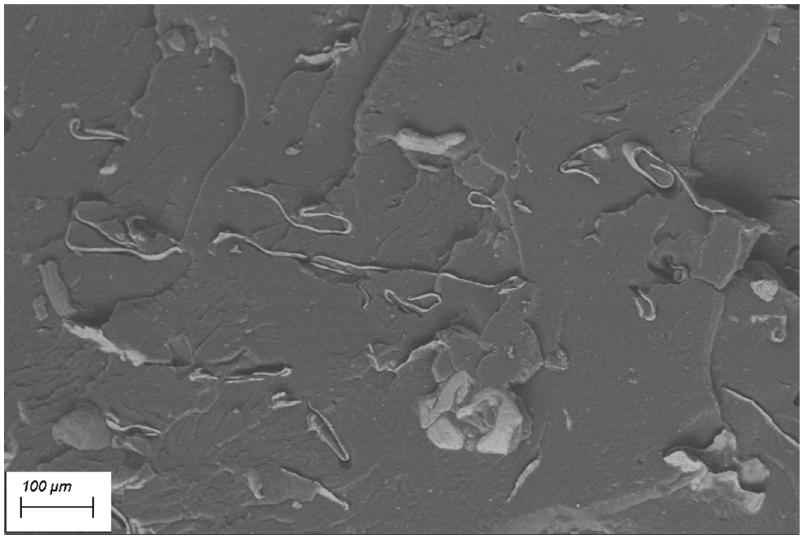
Figure 2. SEM image 250× of compression-moulded PEAL.